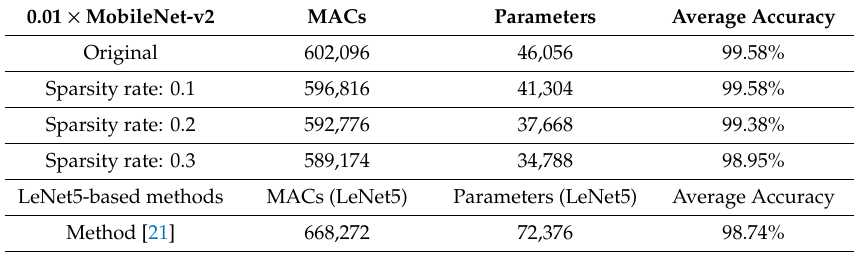
Table 6. Diagnosis performance of the proposed method at a scaling rate of 0.01 and consumed system resources compared with existing methods.